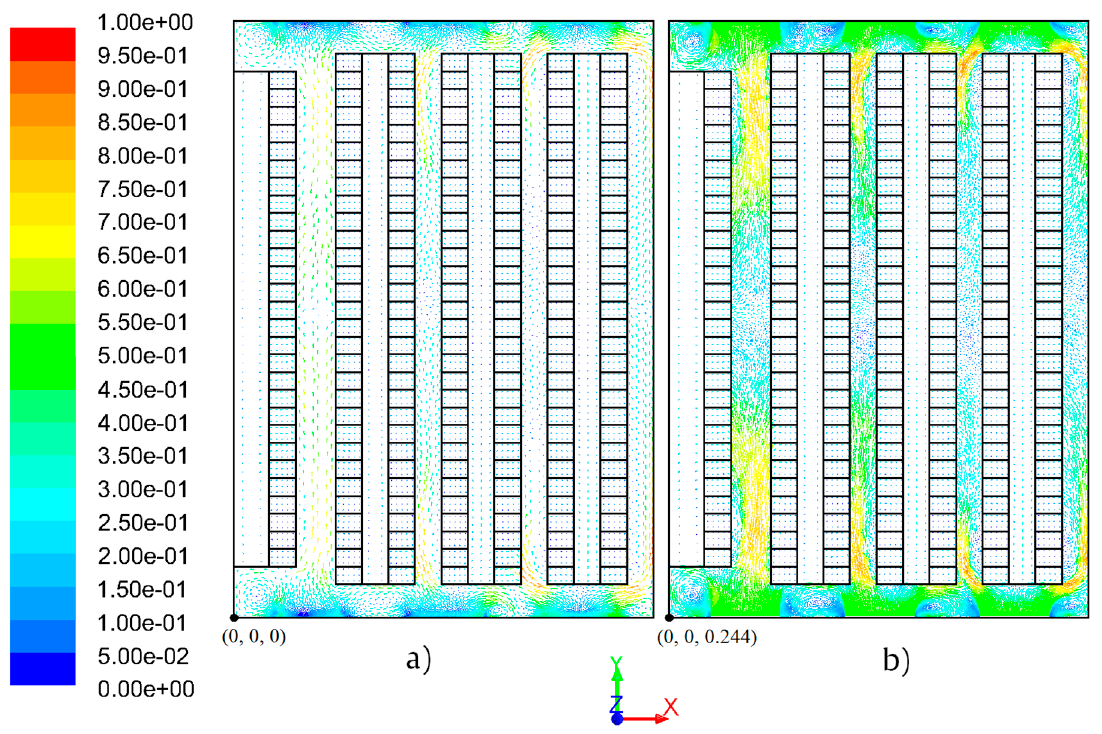
Figure 26. The results of the dimensionless velocity vectors for the maximum air flow velocity in the x–z plane represented through the planes: ( a ) y adm = 0.100; ( b ) y adm = 0.485; and ( c ) y adm = 0.900.